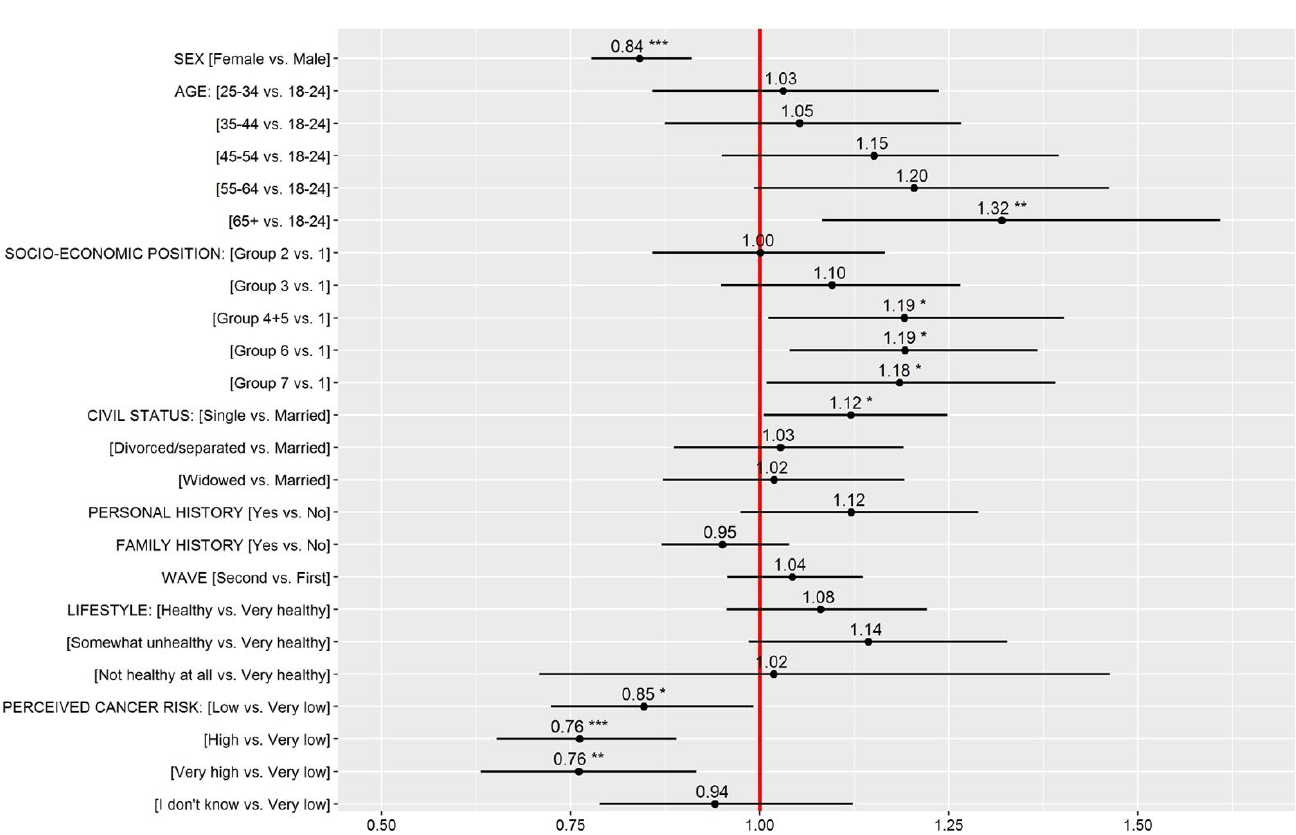
Figure 3. Relative score increases (black dots) and 95% confidence intervals (CI) derived from a Poisson regression model with outcome the number lifestyle risk factors with low perceived influence. Note: * p < 0.05, ** p < 0.01, *** p < 0.001. If the estimated effect and its CIs are to the left of the red reference line, the indicated group has a lower score (i.e., fewer factors with low perceived influence) compared to the reference group. If the estimated effect and its CIs are to the right of the red reference line, the indicated group has a higher score (i.e., more lifestyle factors with low perceived influence) compared to the reference group. For civil status, the category “Married” includes married and cohabiting.